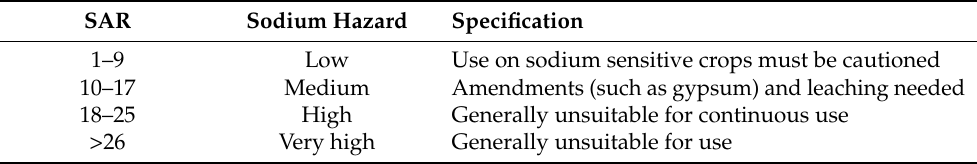
Table 3. General classification of water sodium hazard based on SAR values [22].